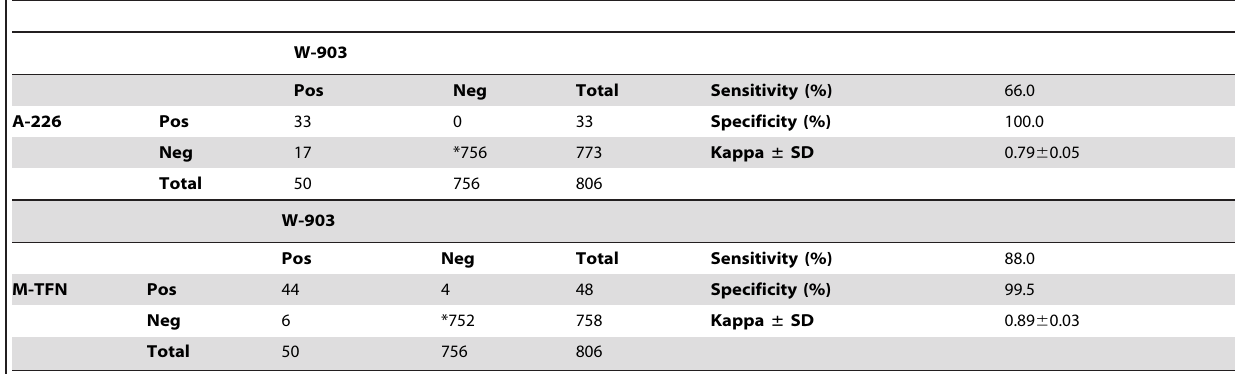
Table 3. Comparison of HIV drug resistance mutations detected in DBS specimens collected on A-226 or M-TFN to